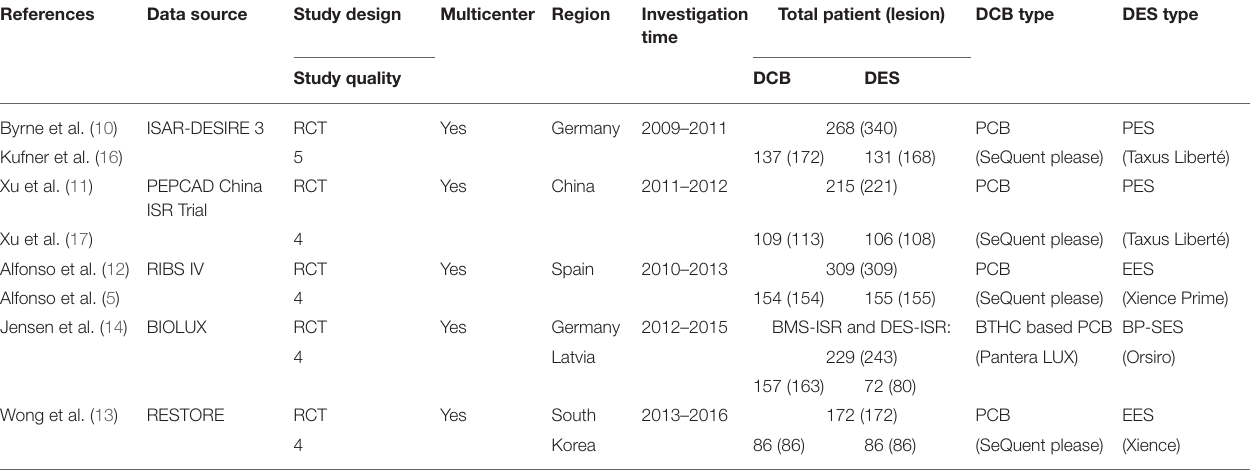
TABLE 1 | Main characteristics of the included